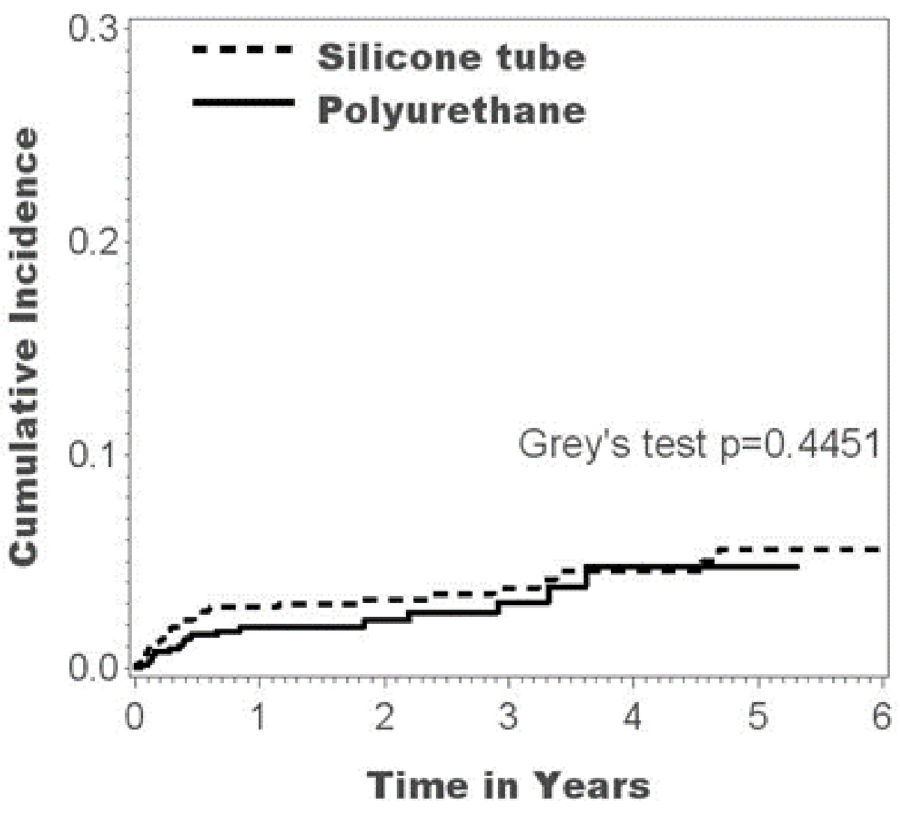
Fig 2. Cumulative incidence of